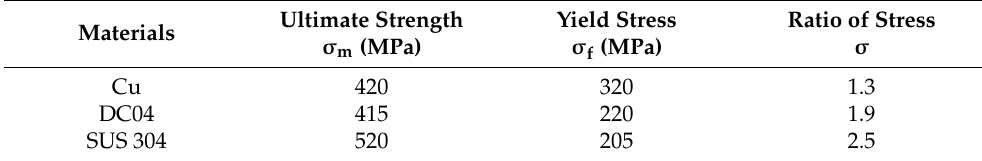
Table 1. Properties of materials.